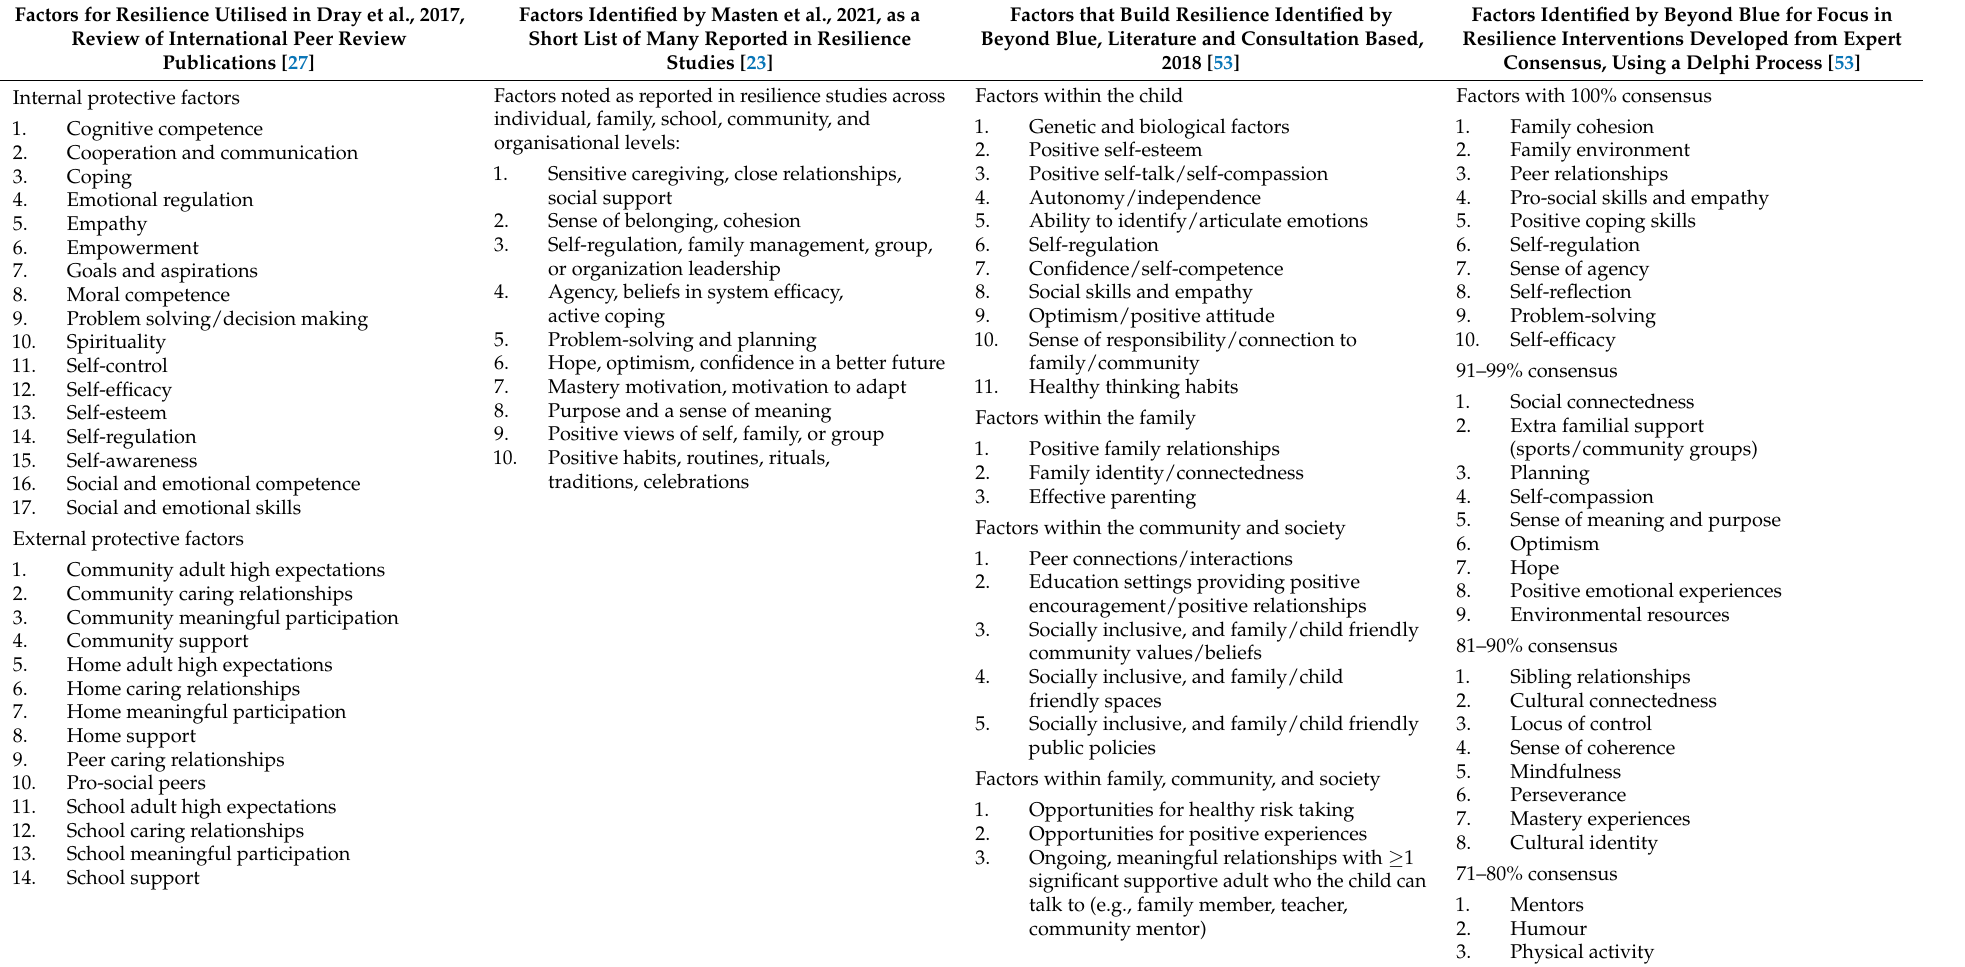
Table 1. Sample of sources demonstrating the large variability in factors identified as relating to